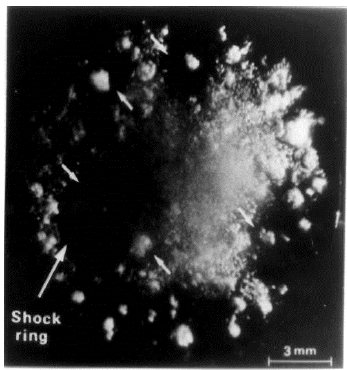
Figure 10. Aspect of cavitation induced by vibratory apparatus [70]. Reproduced with permission from The Japan Society of Mechanical